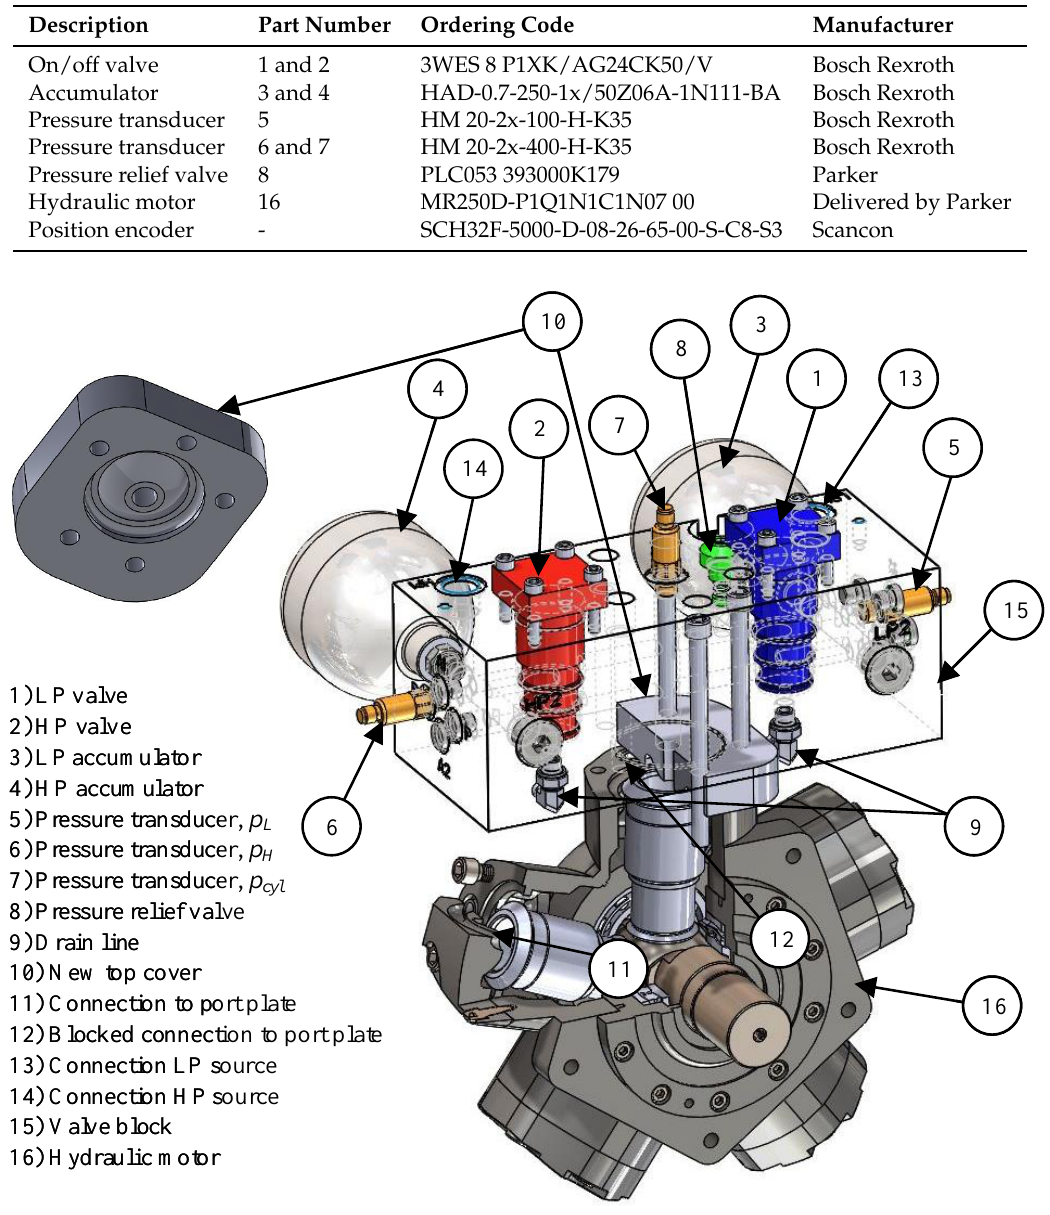
Figure 11. Illustration of the modified radial piston